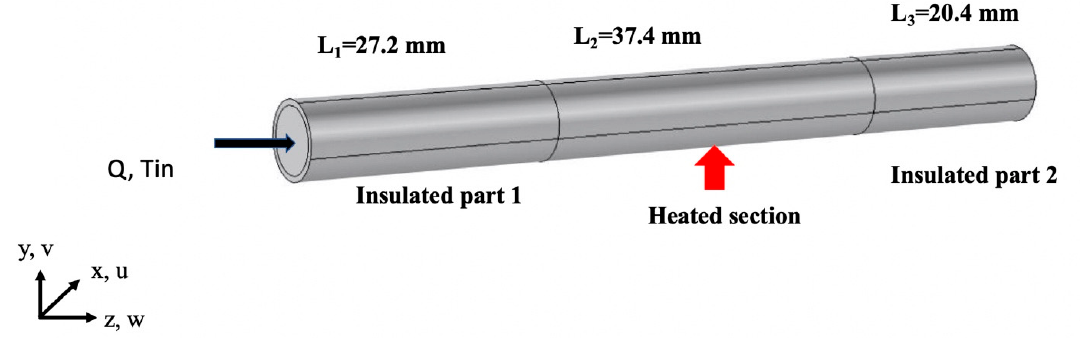
Figure 1. Pipe configuration.